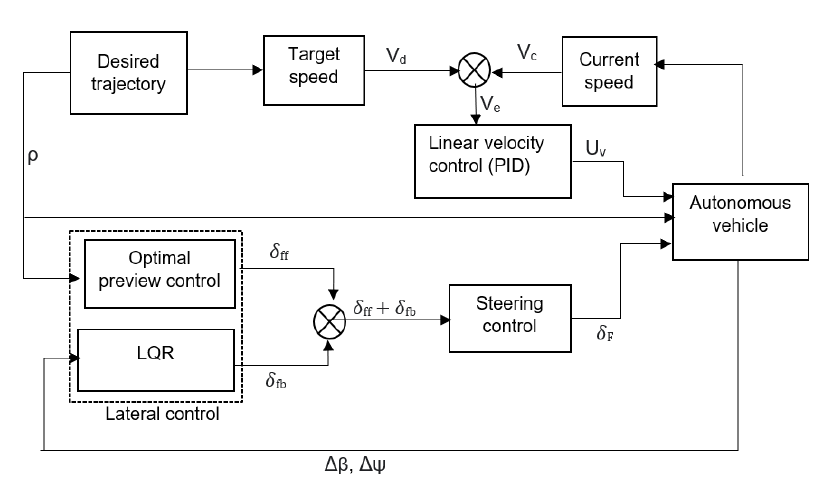
Figure 1. Architecture overview of proposed